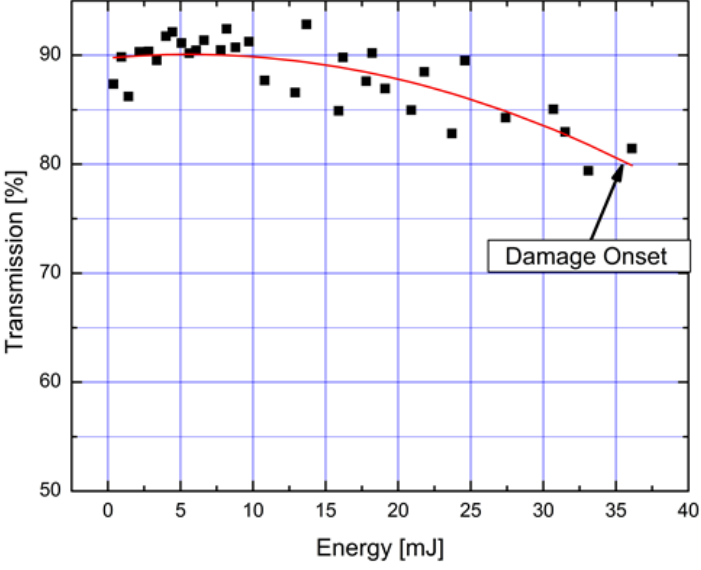
Figure 6. Example of fiber transmission as input energy was increased, for case where fiber fails at input tip (30 ns pulse duration).